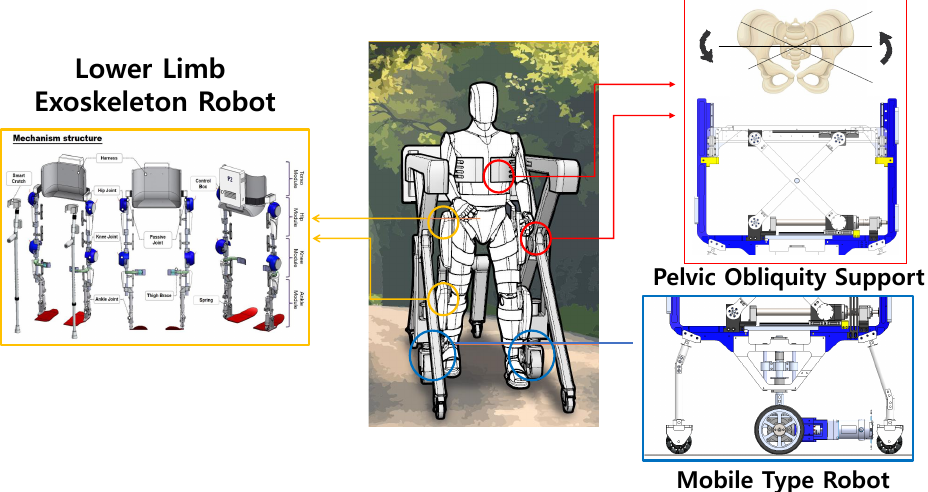
Figure 1. Concept of pelvic obliquity support robot. The red square represents the two scissor mechanisms located on each side of the patient. The scissor mechanisms support the pelvic frontal plane motion of the patient. The blue square represents the mobile-type robot. The drive wheel provides the system with mobility, thus allowing patients to undergo overground gait rehabilitation. The yellow square represents the lower-limb exoskeleton robot. The exoskeleton robot assists the hip and knee flexion/extension motion on the sagittal plane. The pelvic support robot and exoskele- ton robot are integrated, and this integration facilitates patients with multiple degrees-of-freedom movement during gait